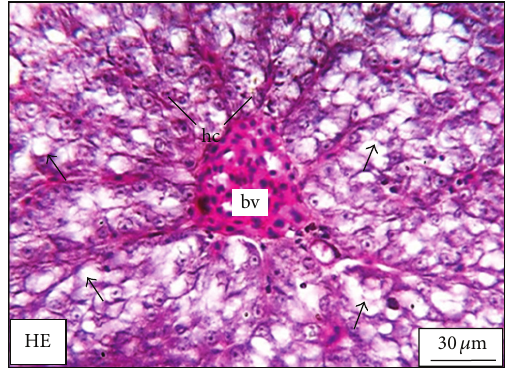
Figure 2: The histological section of the liver of a mature adult Mystus tengara during the spawning phase (June) showing large reserve of fat cells (small black arrow) and enlarged hepatocytes bearing prominent nuclei (hc). The section also shows a ramified blood vessel (bv) at the centre of the tissue under controlled condition [HE: Haematoxylin-Eosin stain].